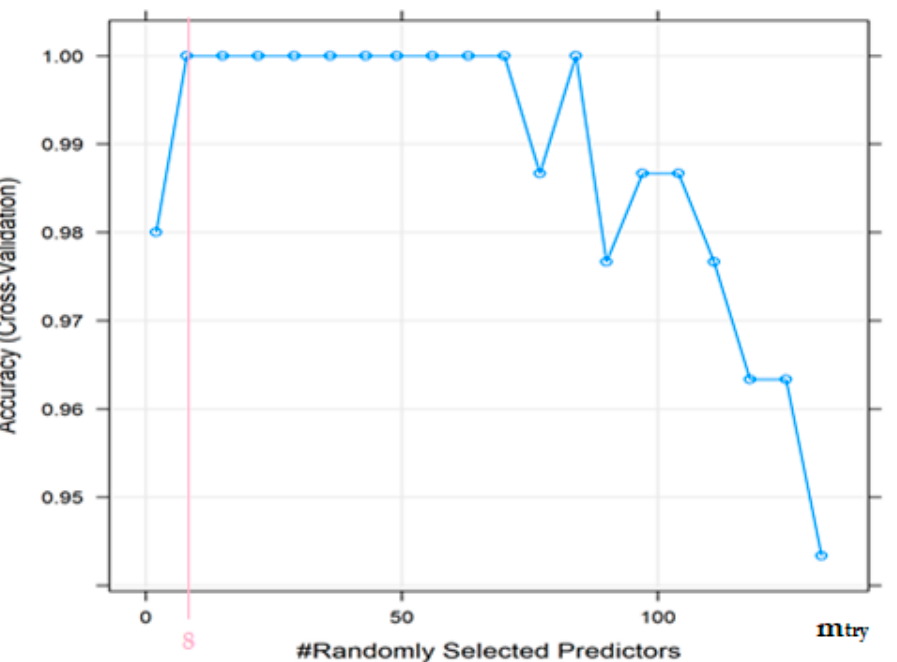
Figure 6. The accuracy of the Random Forest model as a function of the value of the mtry parameter. Detailed accuracy and kappa values for the four algorithms tested are shown in Table 3. Table 4. Training dataset—purchase of EV car—prediction and observation. The model fit was very good. Except for the test and training sets, the accuracy did not differ significantly, so no overfitting occurred. The selected parameters were then optimized to improve the performance of the algorithm. Fourteen variables with the highest predictive value in the model were plotted. This is shown in Figure 7. The greater the value of “mean Decrease in accuracy” ( x -axis) is, the greater is the influence of the variable under study on the prediction of EV purchase intention.